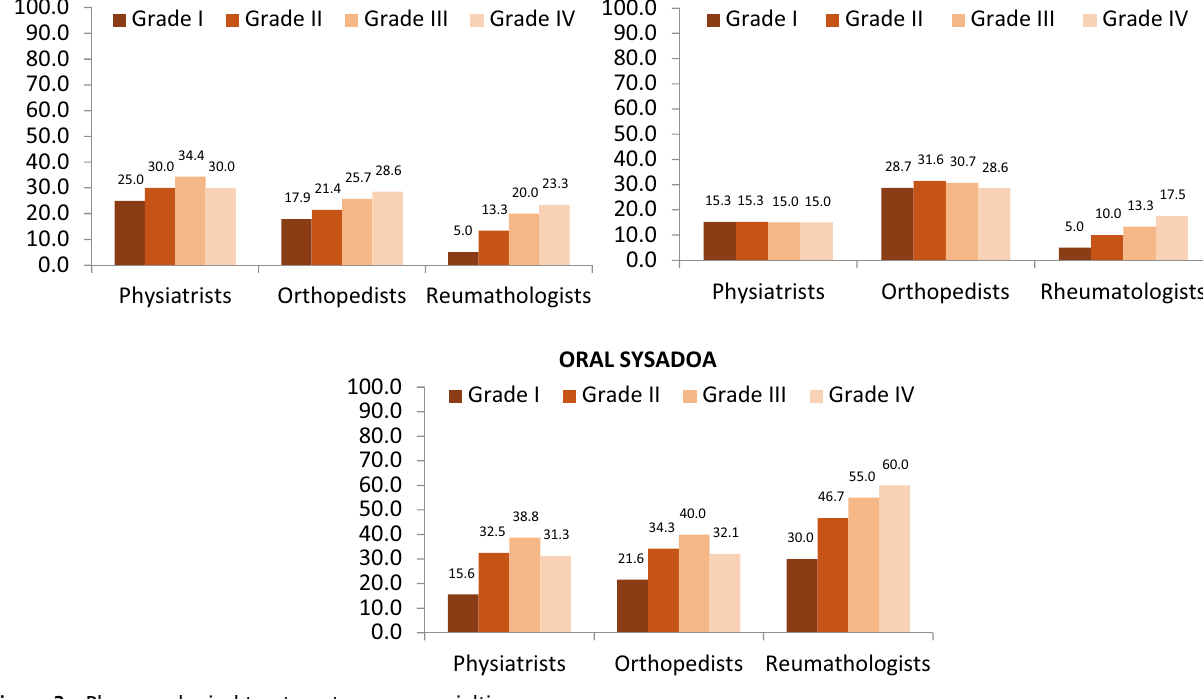
Figure 3 – Pharmacological treatment among